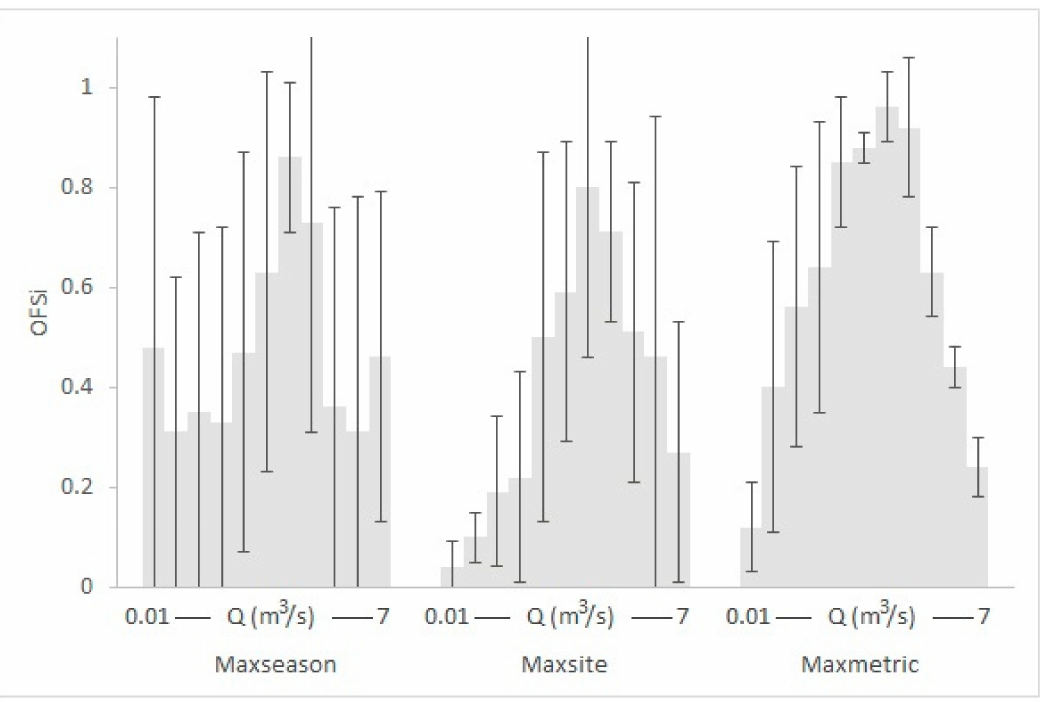
Figure 4. Graphical representation of the Seasonal optimal flow scenario (OFS) means (grey shaded) and standard deviations within the various κ -normalization alternatives for the Parapeiros reach. The OFS values of spring, summer and autumn for each discharge (Q) have been averaged.